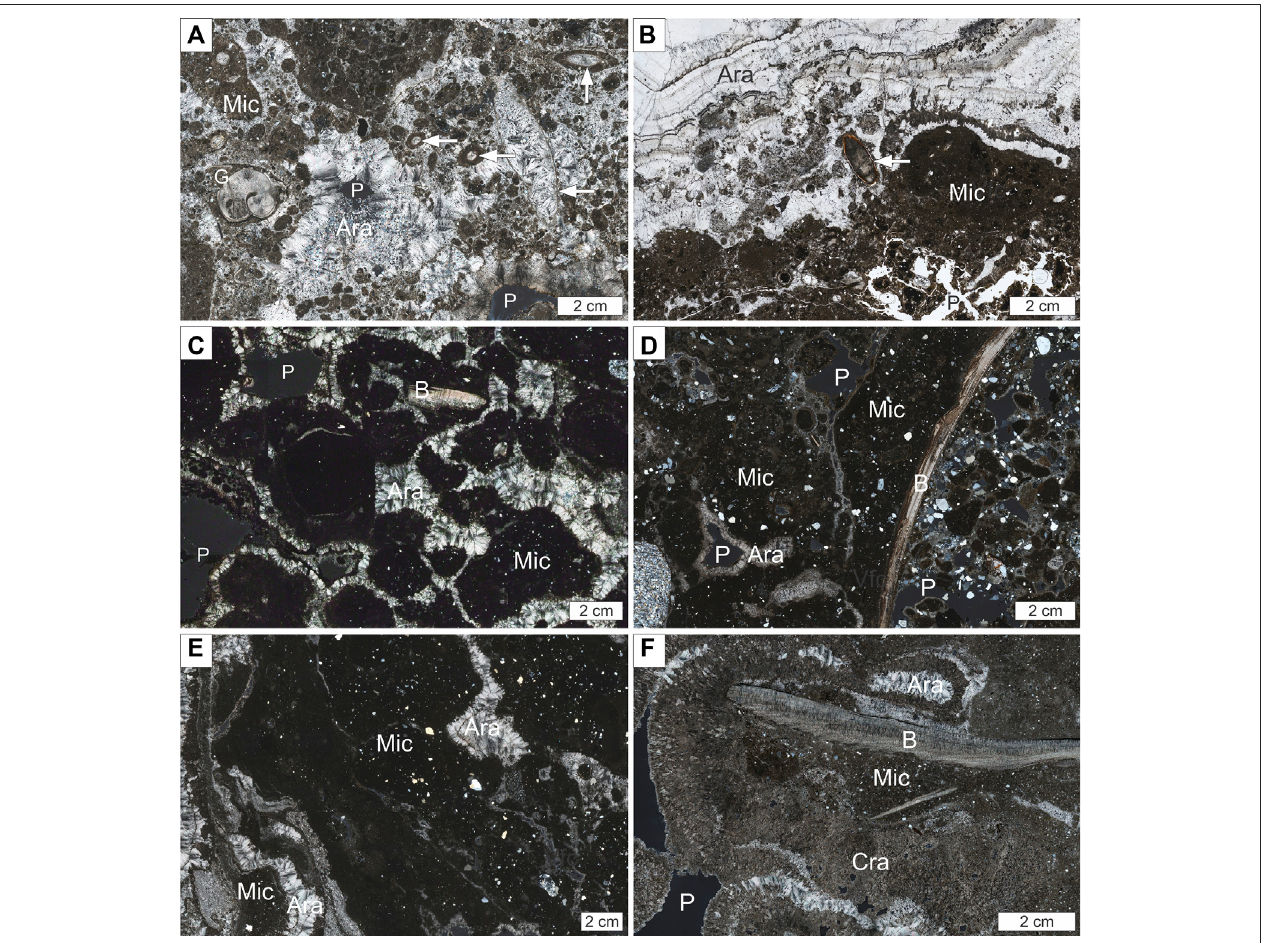
FIGURE 3 | Representative photomicrographs (stitched tiles) of the seep carbonate crusts. (A) Microcrystalline aragonite-cemented sediment (Mic) clasts with abundant silt-sized quartz, gastropod fragment(G), and abundant clotted micrite clasts and peloids cemented by botryoidal and fi brous aragonite ( Ara ); arrows point to cemented tube worm tubes; cross-polarized light, pore space (P) appears dark [sample HH 1029 (S-1)] (B) Porous (P) microcrystalline aragonite-cemented sediment (Mic) with abundant silt-sized quartz (lower image half) and cm-thick aragonite cement ( Ara ) with abundant clotted micrite inclusions and multiple thin dark bandings; arrow points to tube worm [parallel-polarized light, pore space appears bright; HH 1077(S-2)]. (C) Microcrystalline aragonite-cemented sediment (Mic) clasts withabundantsilt-sizedquartzcementedbybotryoidalaragonite( Ara );noteabivalveshellfragment(B);cross-polarizedlight,porespace(P)appearsdark[P1606002(V- 1)]. (D) Microcrystalline aragonite-cemented sediment (Mic) with abundant silt to fi ne sand sized quartz; not quartzite pebble (lower left) and bivalve shell (B); pores and fractures are lined with botryoidal and fi brous aragonite ( Ara ); cross-polarized light, pore space (P) appears dark [P1606011(V-2)]. (E) Microcrystalline aragonite- cemented sediment (Mic) with abundant silt-sized quartz and fracture- fi lling botryoidal aragonite ( Ara ); cross-polarized light [P1606012(V-3)]. (F) Microcrystalline aragonite cemented sediment (Mic) with abundant silt-sized quartz and bivalve fragment (B) surrounded by cryptocrystalline aragonite (Cra) and botryoidal aragonite ( Ara ); cross-polarized light, pore space (P) appears dark [GeoB21616-1-2R-1 E (V-4)]. (C – F) adapted from Himmler et al.